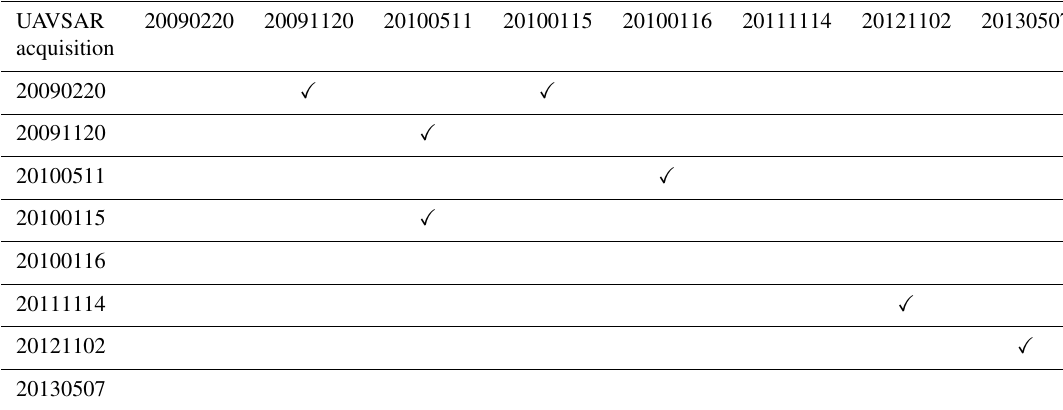
Table A1. UAVSAR acquisitions and InSAR